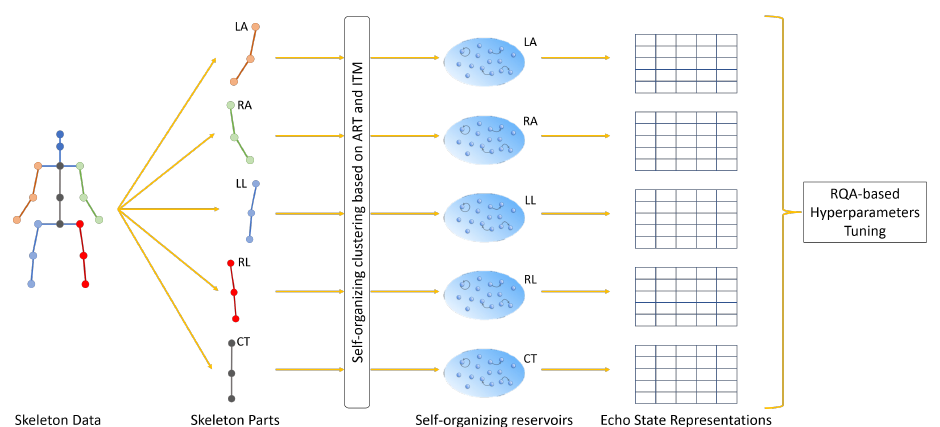
Figure 2. Five channels from human skeleton data: left arm (LA), right arm (RA), left leg (LL), right leg (RL), and central trunk (CT) are first extracted during data preparation. Then, SORN learning generates the respective self-organizing reservoirs independently. RQA is applied on the corresponding ESRs for hyperparameter